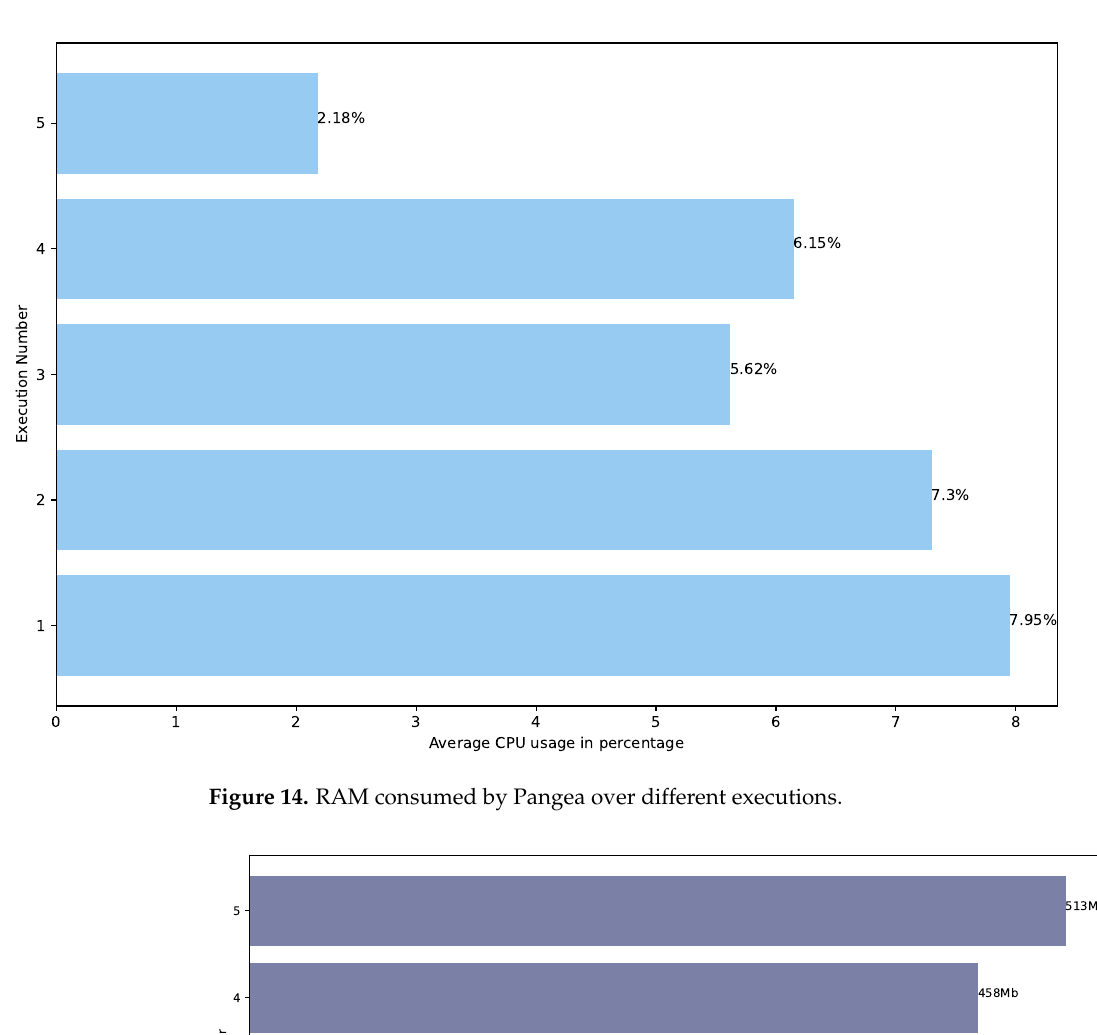
Figure 14. RAM consumed by Pangea over different executions.